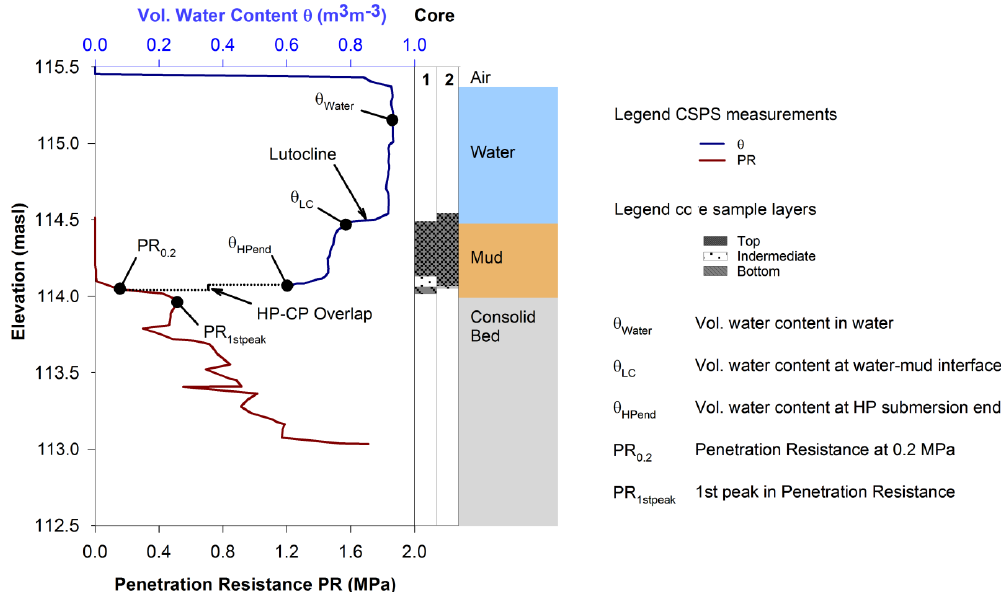
Figure 2. Characteristic features highlighted in a typical CSPS profile.